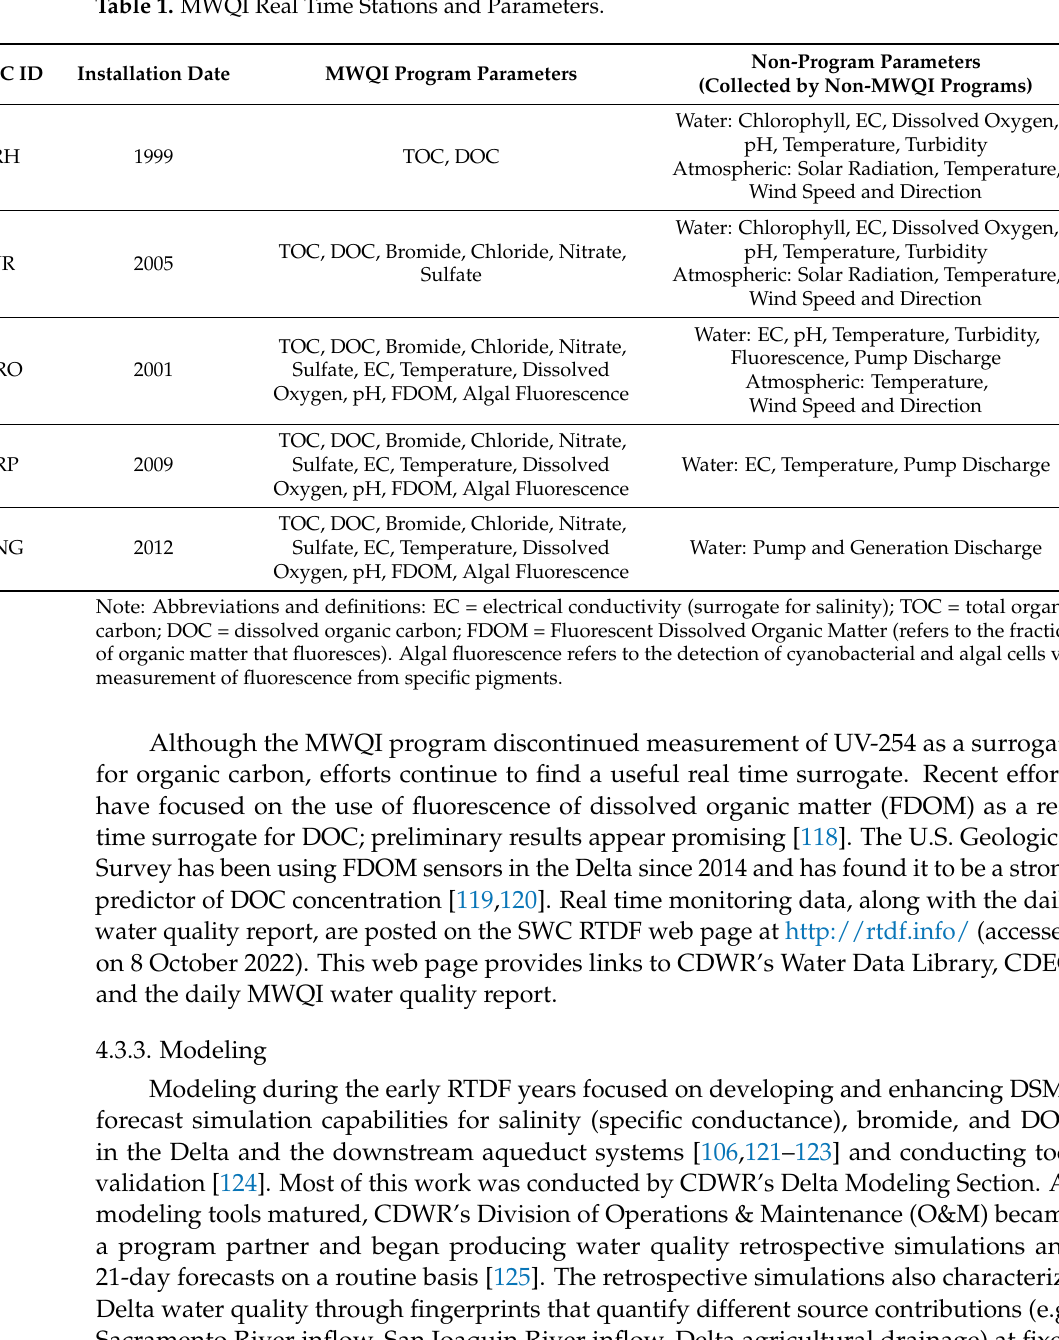
Table 1. MWQI Real Time Stations and